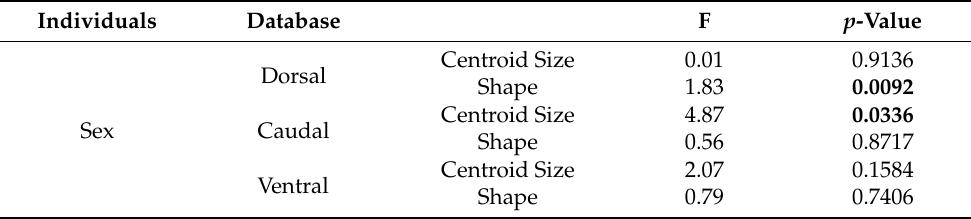
Figure 5. Scatter plot of PC1 (34.495) and PC2 (22.679) of quails for ventral view ( left ). Wire-frame warp plots of changes in the cranial shape of quail, as mapped by 13 landmarks ( right ). Procrustes ANOVA showed that skull size (as centroid size) differed significantly between the sexes in caudal view, whereas shape differed in dorsal view (Table 2). In other results, there was no difference in the size or shape of the skull between the sexes. Table 2. Procrustes ANOVA results (Bolded: significant difference).